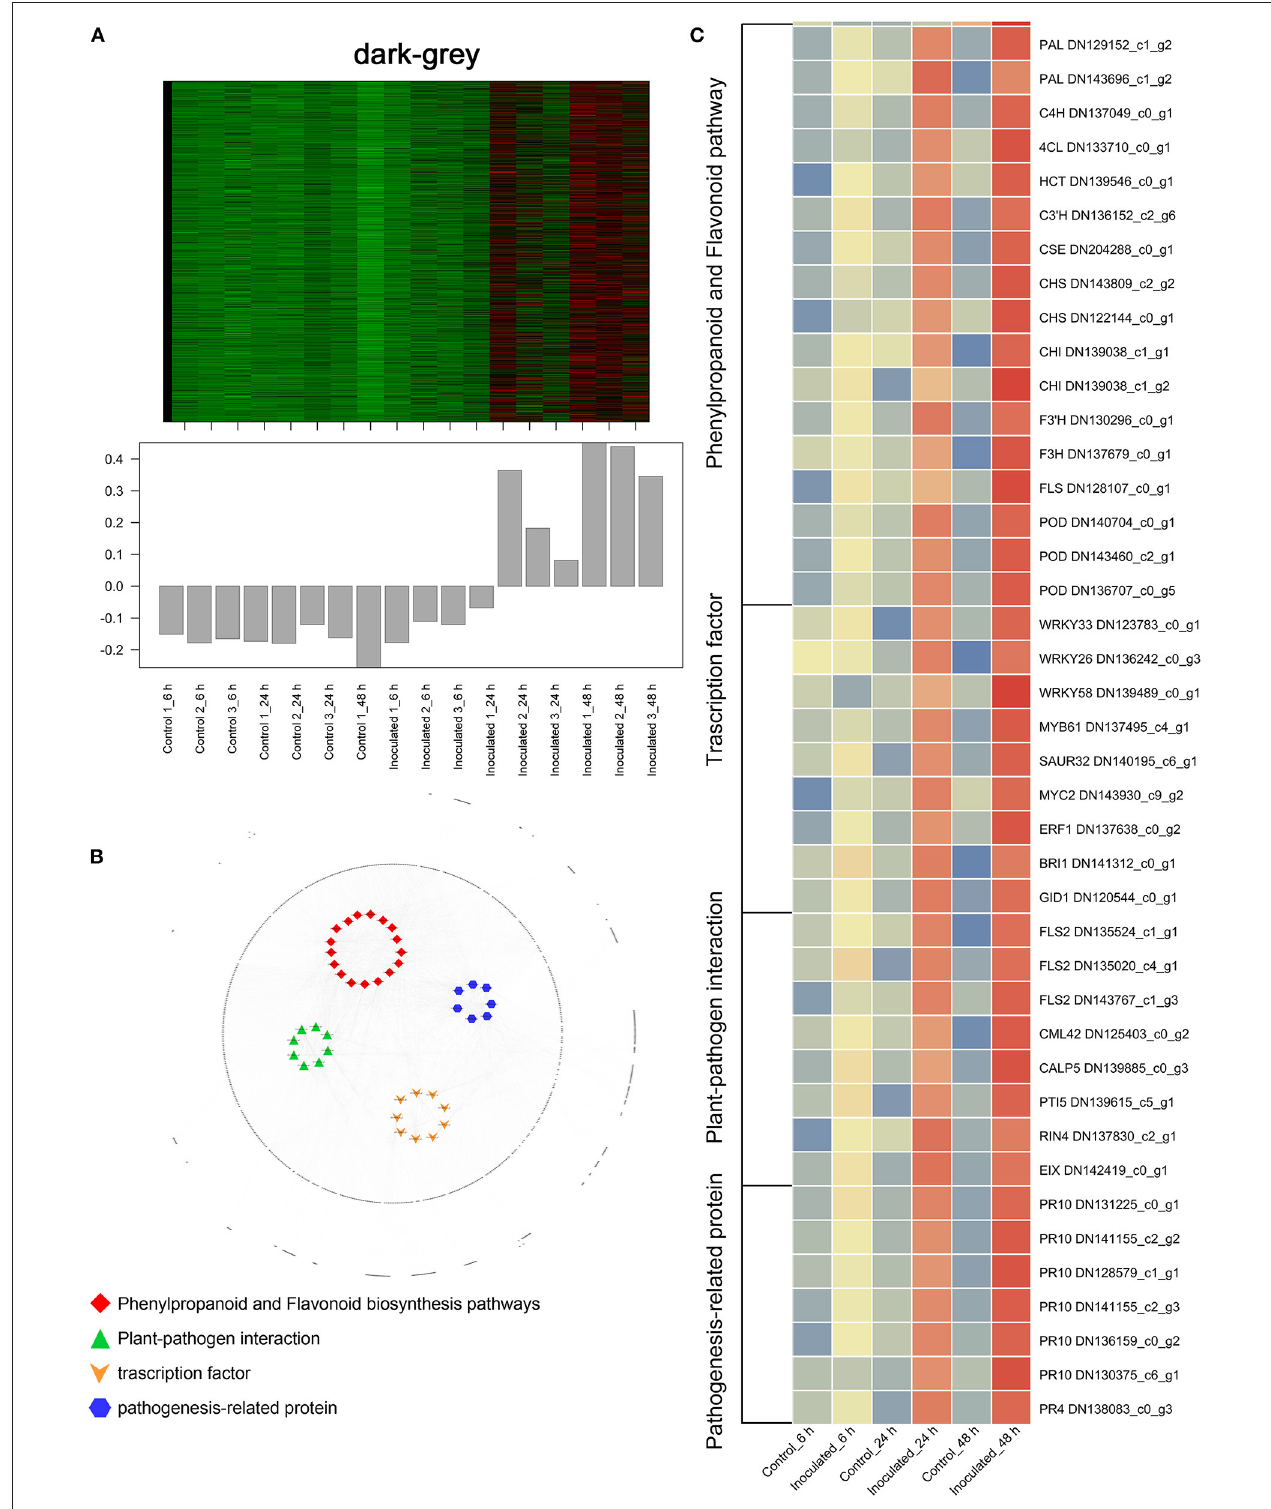
FIGURE 6 | “Sorbonne” DEGs common to all three stages of B. elliptica infection. (A) Heat maps and bar graphs show the co-expressed genes in each module. Red rectangles denote high expression levels; green rectangles denote low expression levels. (B) Network of hub genes is indicated by larger font size in the network. Small dots around the hub genes represent other co-expressed genes, and their relationships are connected by lines. Red squares represent the phenylpropanoid and flavonoid pathways; green triangles represent plant–pathogen interactions; orange arrows represent transcription factors (TFs); blue hexagons represent pathogenesis-related (PR) proteins. (C) Heat maps showing the expression patterns of hub genes.